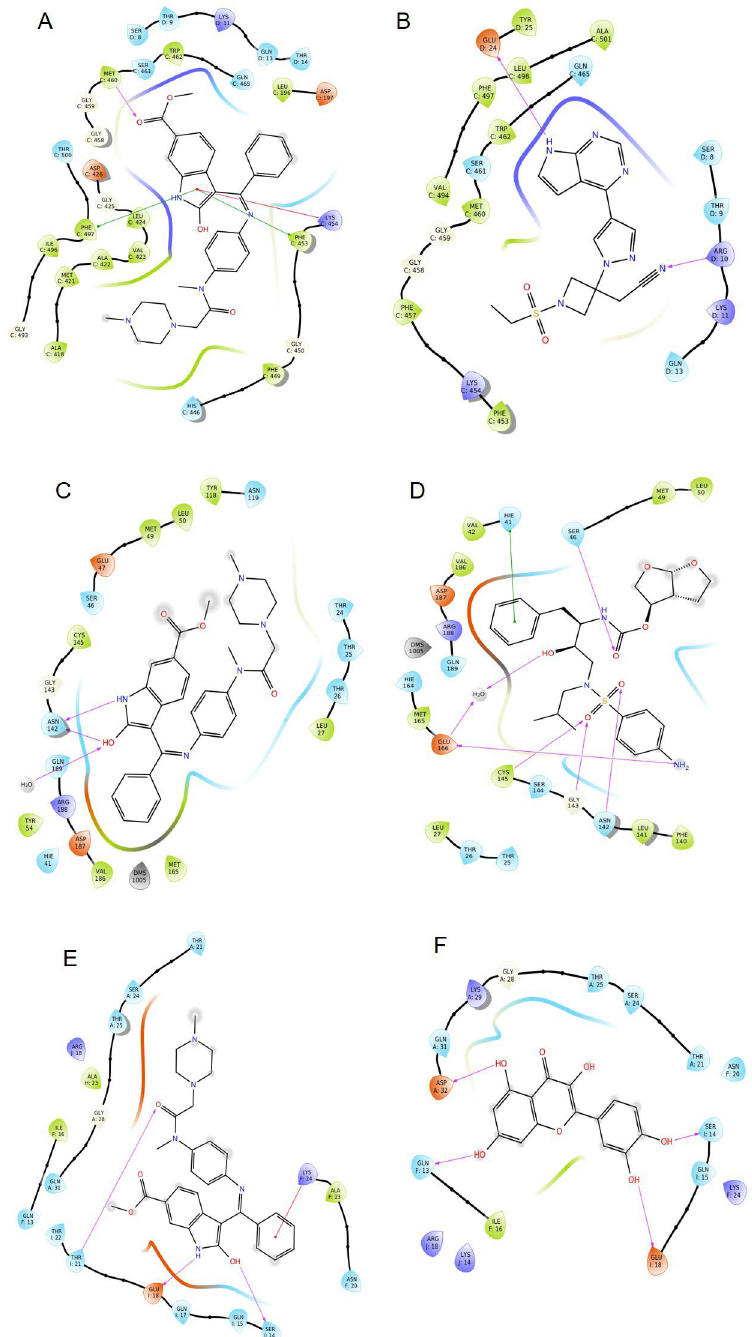
Figure 1. 2D ligand-interaction diagram on SARS-CoV-2 proteins. ( A , B ): Nintedanib and Baricitinib on ACE2 Protein, PDBID 6M1D; ( C , D ): Nintedanib and Darunavir on M pro , PDBID 5R82; ( E , F ): Nintedanib and Quercetin on Spike Protein. PDBID: